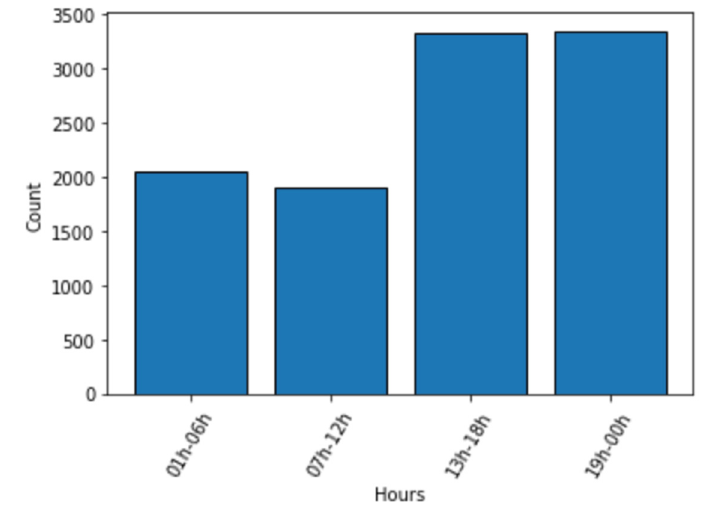
Figure 5. Histogram of complaints by time intervals.